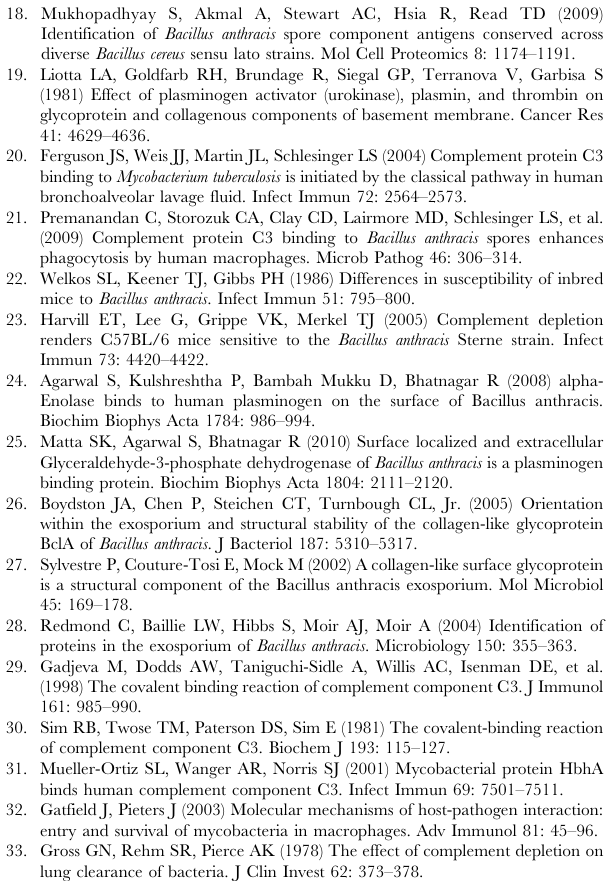
Table S1 Identification of human serum proteins interacting with B. anthracis spores separated by 2D SDS-PAGE. Spore-bound serum proteins were separated onto 2D SDS-PAGE and the each spot excised from the gel was subjected to LTQ-MS/MS.